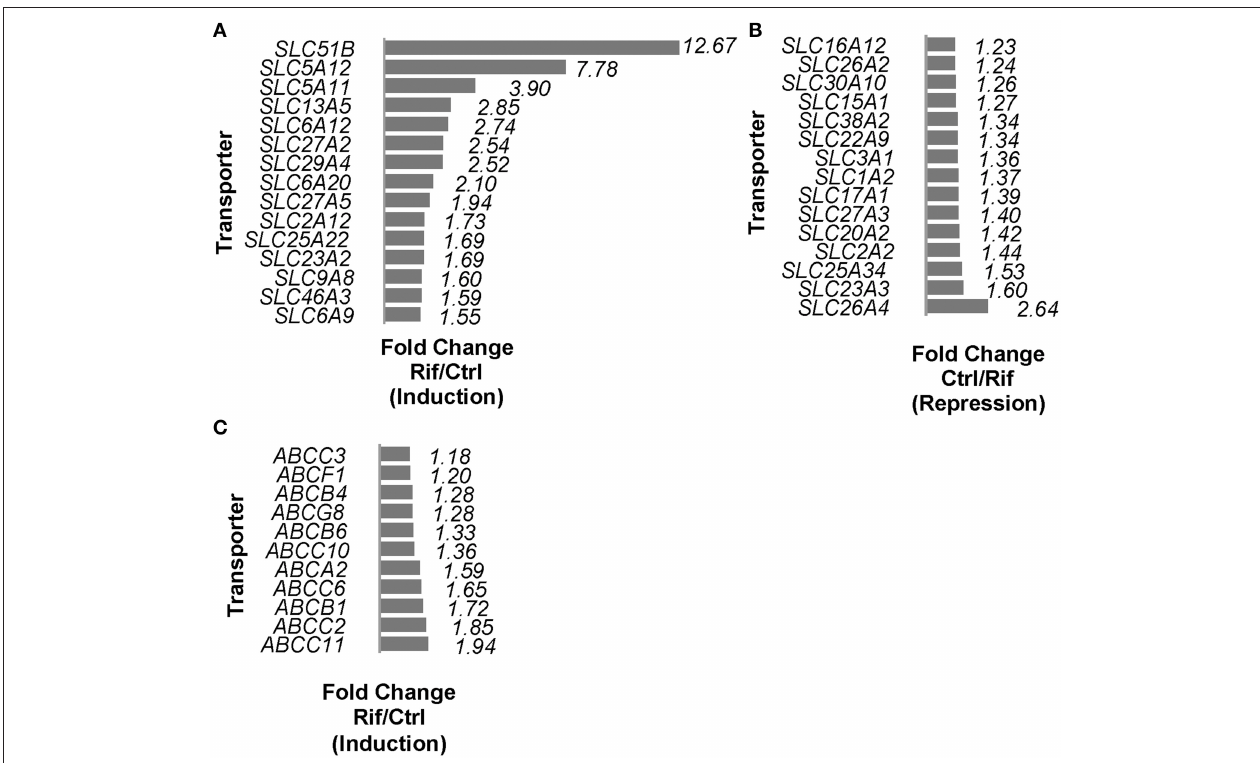
FIGURE 1 | SLCs (including SLCOs ) and ABCs mRNA expressions regulated by rifampin with FDR < 0.05. (A) Induction of SLCs by rifampin by fold change (fold change represented as rifampin/control) (FDR < 0.05); the top 15 SLCs are shown. (B) Reduction of SLCs by rifampin by fold change (fold change represented as control/rifampin) (FDR < 0.05); the 15 most reduced SLCs are shown. (C) Rifampin induced 11 ABC transporter genes based on fold change (rifampin/control) with FDR < 0.05. A fold change equal to 1 is defined as no change, and a fold change of 2 is defined as 2x the